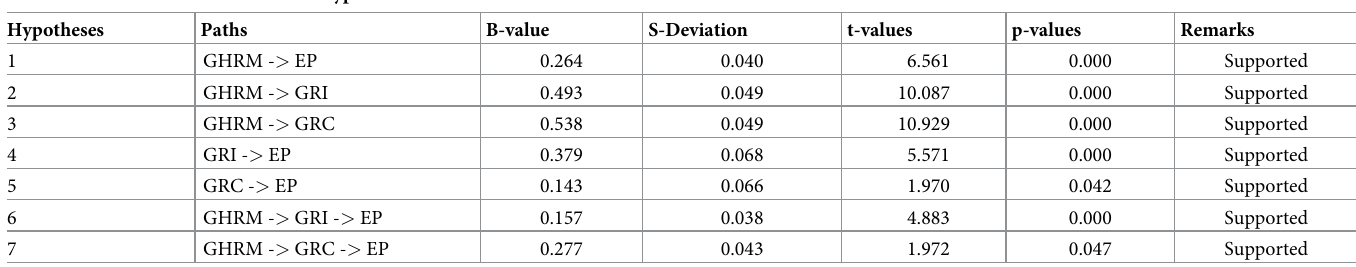
Table 5. Direct and indirect effects of